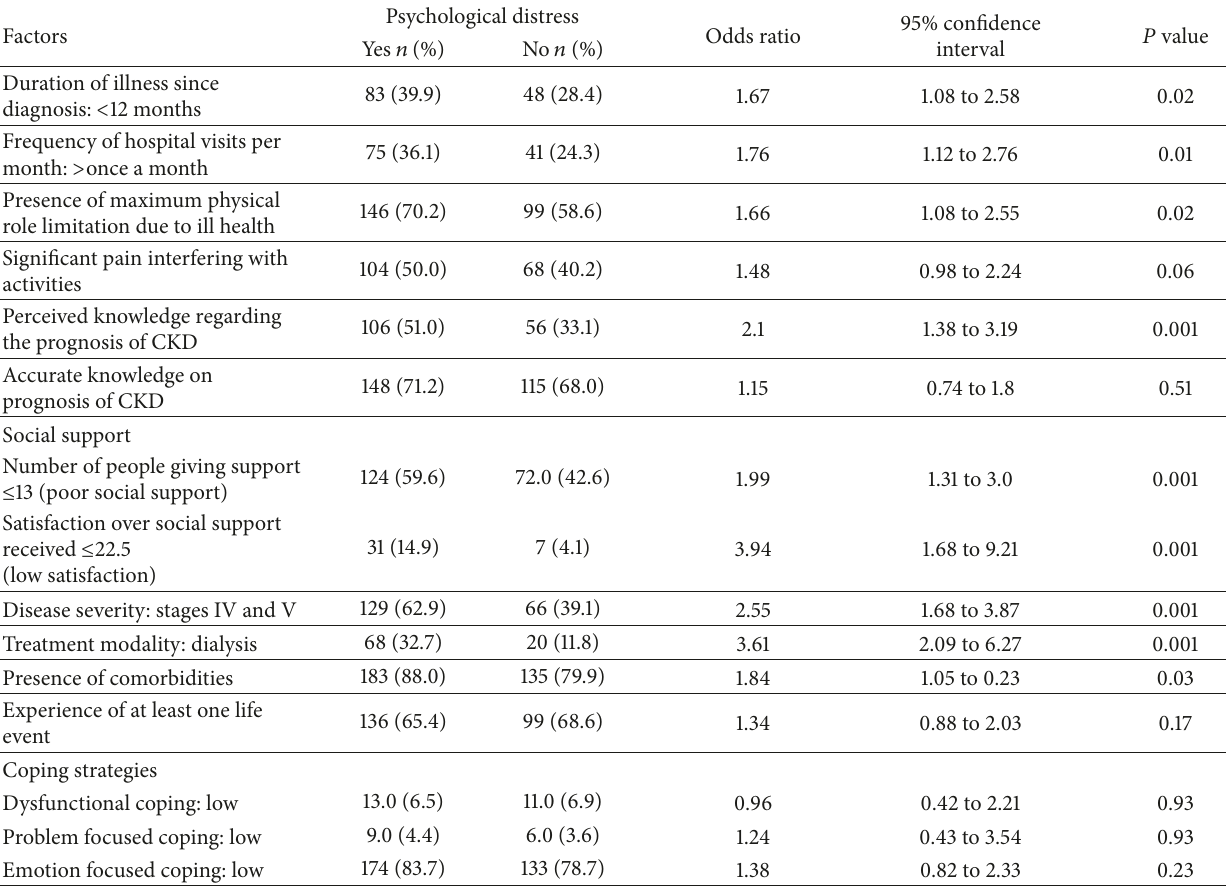
Table 3: Unadjusted odds ratios of social and disease related factors and psychological distress.